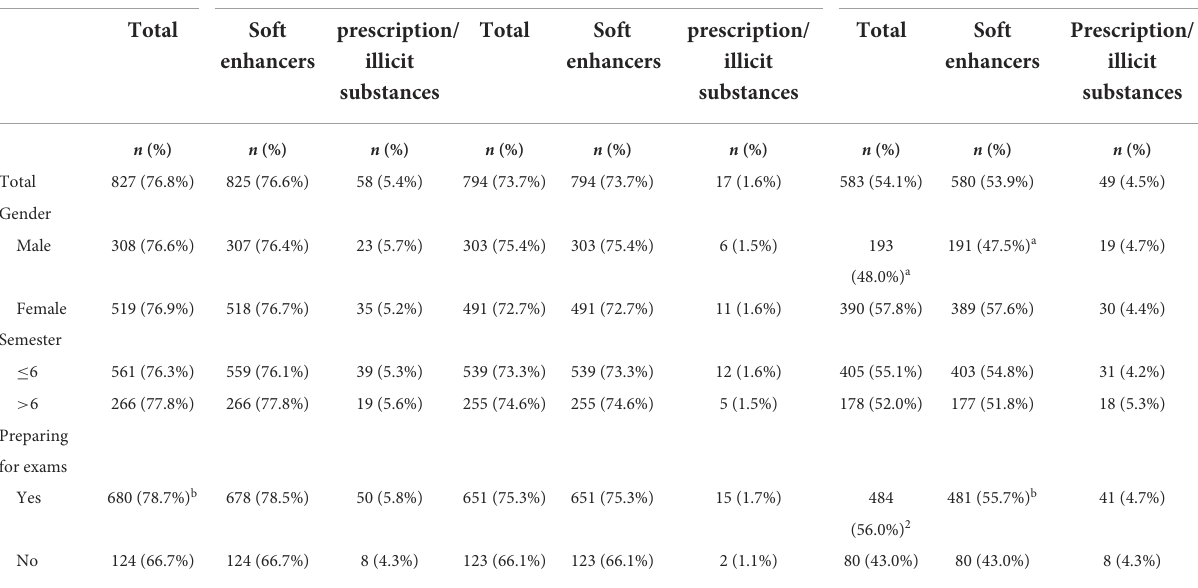
TABLE 1 Pharmacological neuroenhancement by substance group and reason for use. Total Improvement of cognitive functions